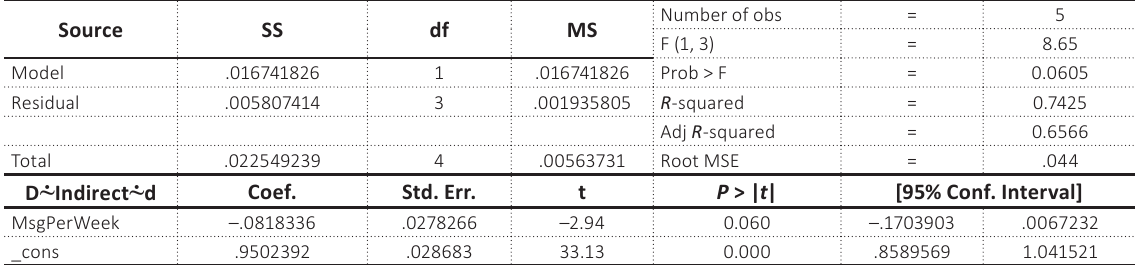
Table 5. Indirect open rate determined by frequency – regression